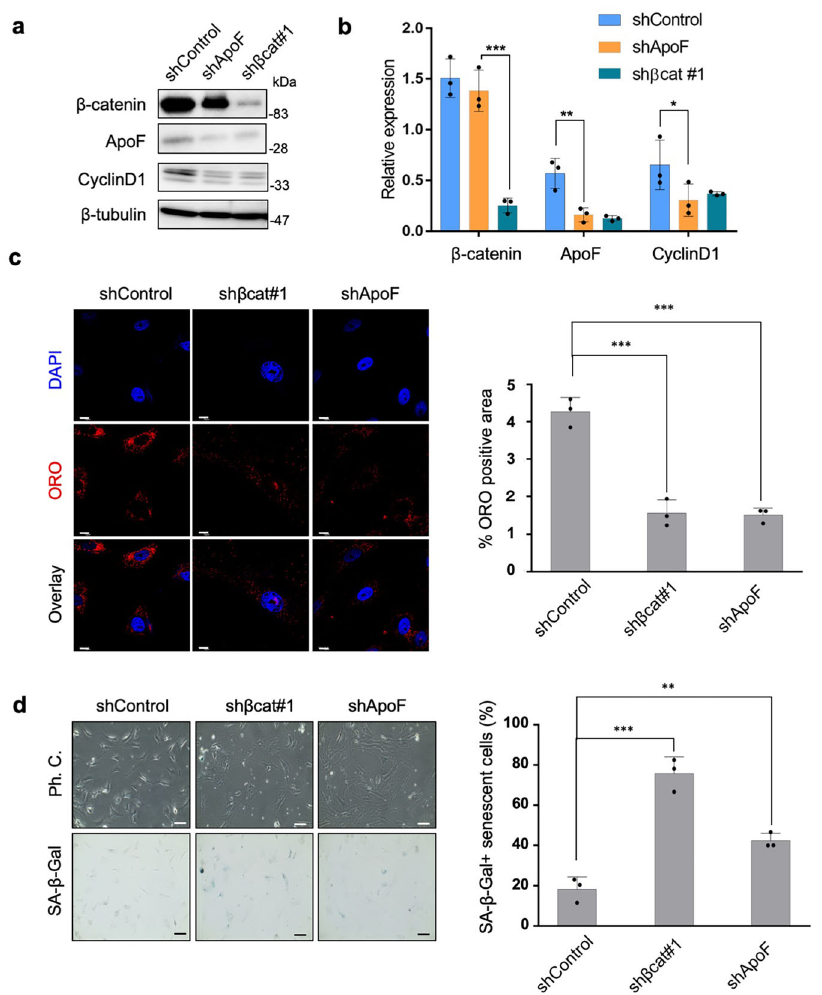
Fig. 6 Knockdown of ApoF or β -catenin has similar effects in NSFs. a Immunoblot con fi rming downregulation of ApoF upon ApoF and β -catenin knockdown in NSFs. β -tubulin was used as a loading control. b Densitometric quanti fi cation of β -catenin and ApoF expression from the immunoblots shown in a . Data are expressed as the mean ± standard deviation ( n = 3 biologically independent experiments). * P < 0.05 and *** P < 0.001, two-sided Student ’ s paired t test. c Immuno fl uorescence images demonstrating decreased abundance of lipid droplets upon β -catenin or ApoF knockdown (left). Scale bars, 10 μ m. Quantitative results showing percentage coverage of cells stained with ORO versus that by total cells in the ORO assay (right). Data are expressed as the mean ± standard deviation ( n = 3 biologically independent experiments). *** P < 0.001, two-sided Student ’ s t test. d Representative images showing SA- β -gal activity in control, β -catenin , and ApoF knockdown NSFs (left). Quantitative analysis of SA- β -Gal-stained cells in control, β -catenin , and ApoF knockdown cells (right). Data are expressed as the mean ± standard deviation ( n = 3 biologically independent experiments); n.s., non-signi fi cant; ** P < 0.01 and *** P < 0.001, two-sided Student ’ s paired t